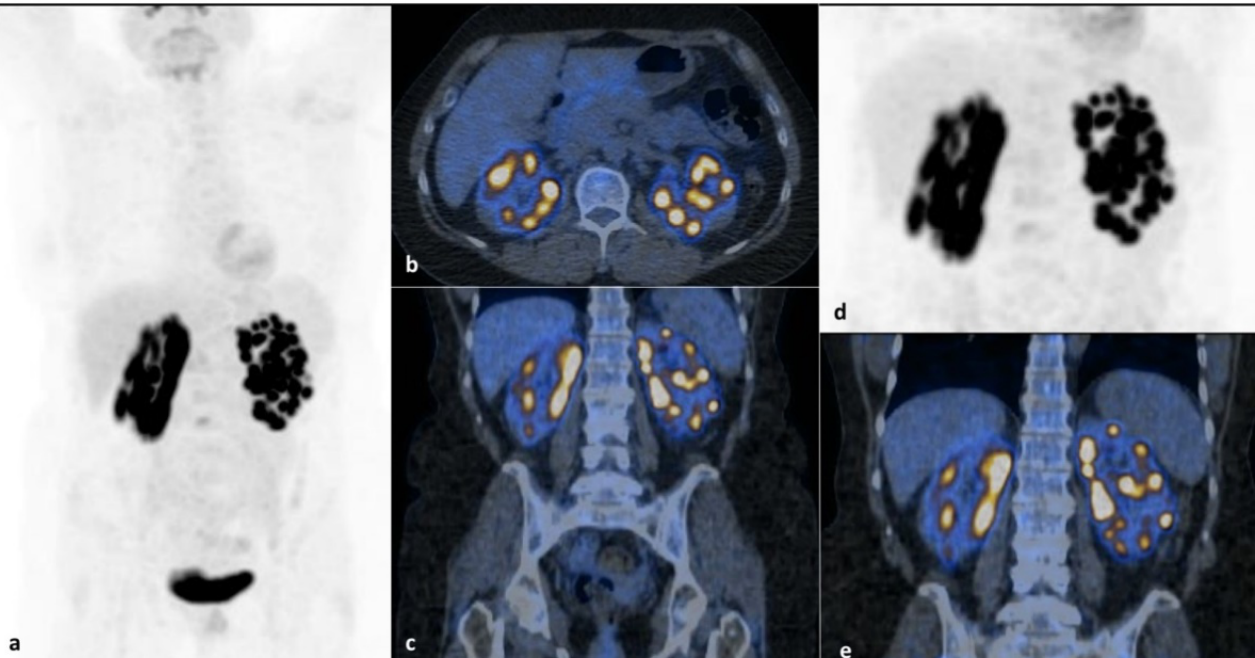
Figure 2. PET/CT imaging revealed multiple areas of intense and focal [ 18 F]FDG uptake in both kidneys at diagnosis (maximum SUV, 20.2). [ 18 F]FDG PET/CTmaximum intensity projection (MIP) ( a ), axial ( b ) and coronal ( c ) fused PET/CT images reveal multiple areas of focal intense [ 18 F]FDG uptake in both kidneys, corresponding to confluent CT-detected nodular lesions without any washout modification on the delayed focused images ( d , e ). Of note, despite the limit represented by radioactive urine interference in the kidneys in this patient, performing a delayed acquisition with or without diuretic administration could help in discriminating physiological uptake from the pathological one.No further areas of pathological [ 18 F]FDG uptake were found in the remaining body segments. Radiopharmaceutical accumulation in the bladder is referred to physiological [ 18 F]FDG excretion ( a ).